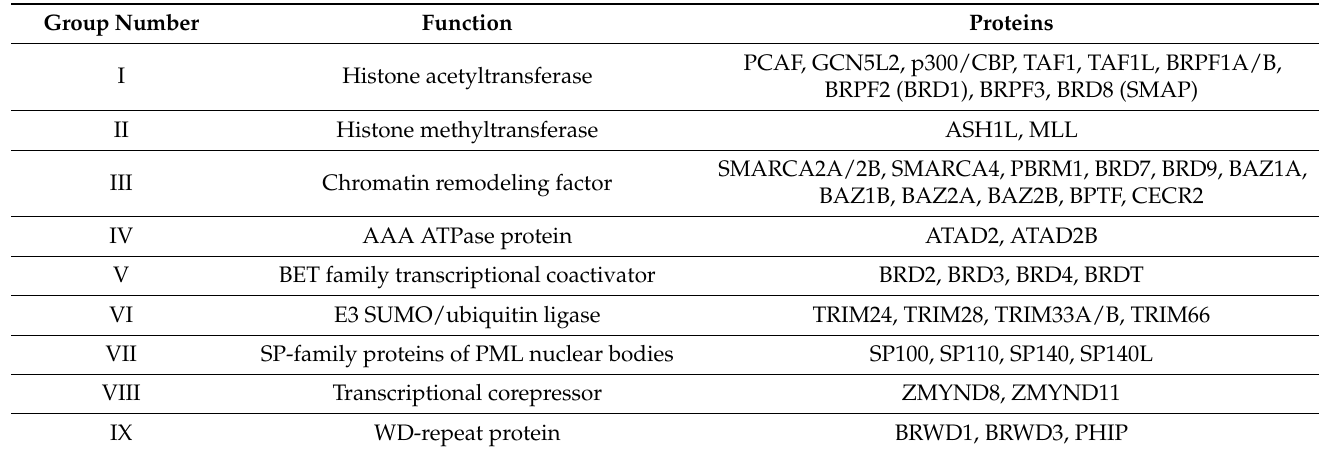
Table 1. Classification and function of BrD-containing